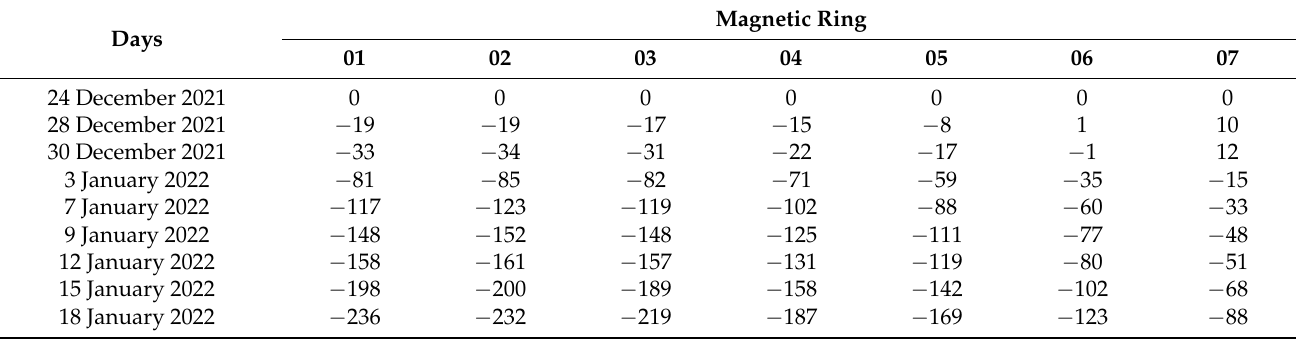
Table 3. Layer sedimentation monitoring results (unit: